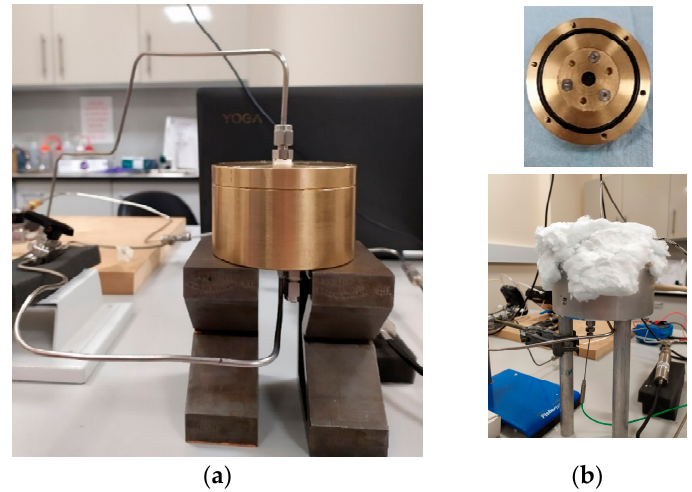
Figure 5. Gas adsorption brass cell ( a ) and sampler holder/isolation of the cell ( b ). Activated carbons obtained as described previously were pelletised using ashes from palm oil as the binding agent, in a mass ratio of 3:2. Corresponding amounts of ACs and